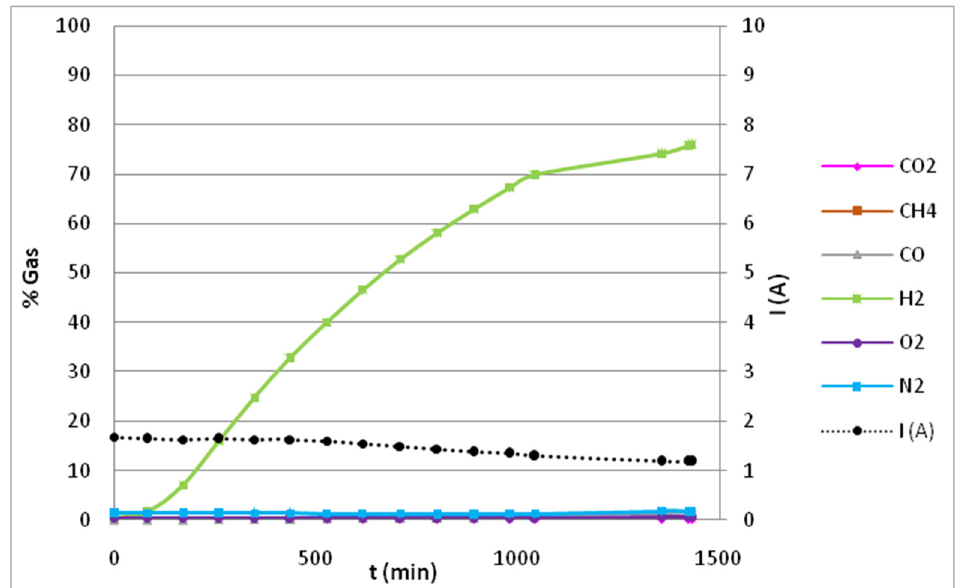
Figure 6. Temporal evolution of generated gases (%) and current (black trace) in the electro-oxidation process of olive mill wastewater (75.0% vol. and KOH 0.5 M) with electrodes at a constant voltage of 3.5 V. Results show that the alkaline electro-oxidation of the olive mill wastewater, in a single cavity electrolyzer, generates hydrogen with no production of other gases, such as carbon dioxide or oxygen, due to the total oxidation of the organic compound.